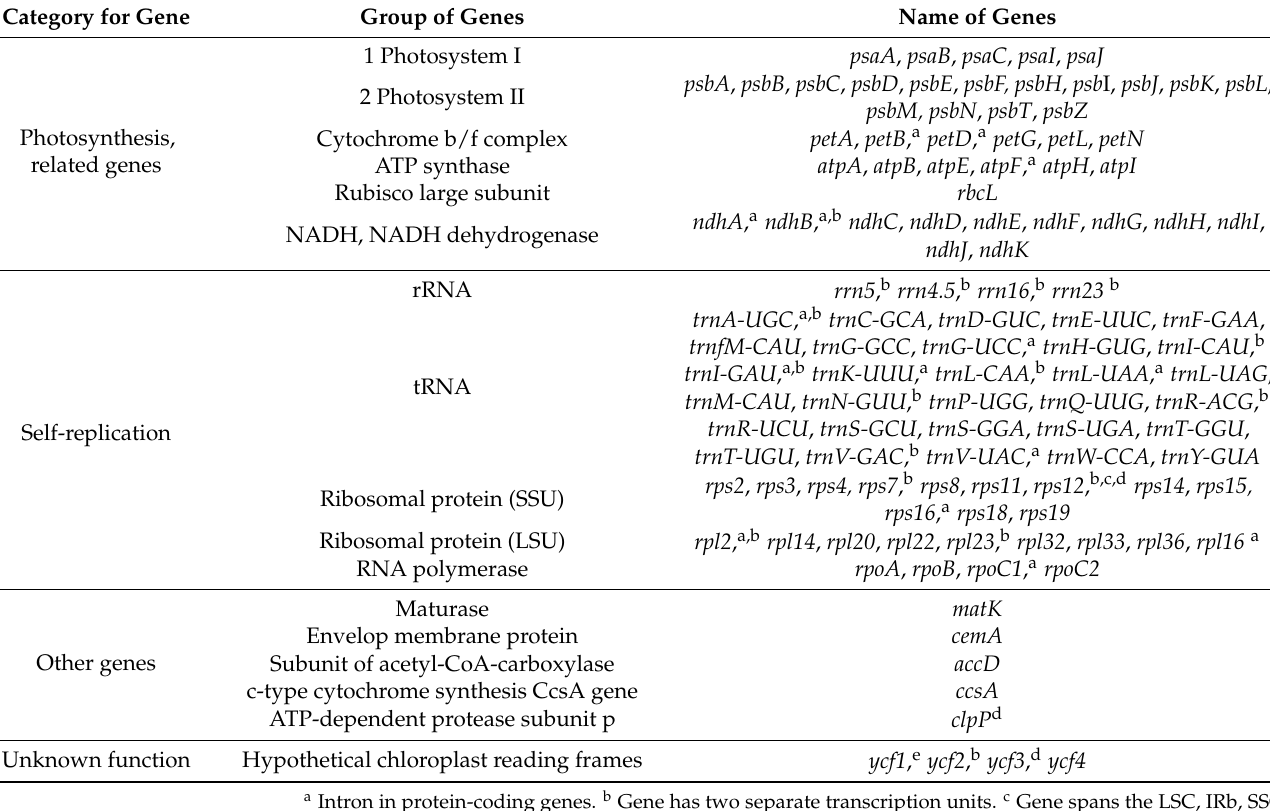
Table 2. Genes of Mangifera, separated by